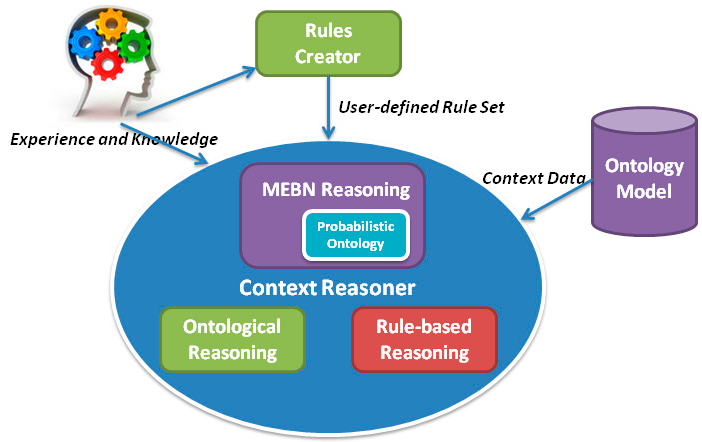
Figure 4. The hybrid context reasoning method for the context reasoner component.